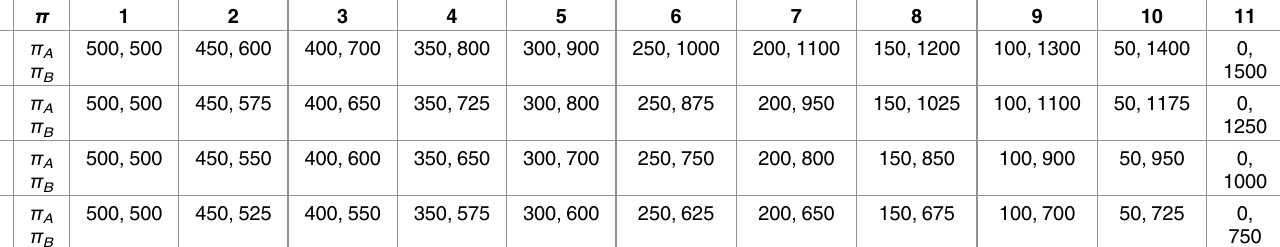
Table 2. Payoffs in the four give games.